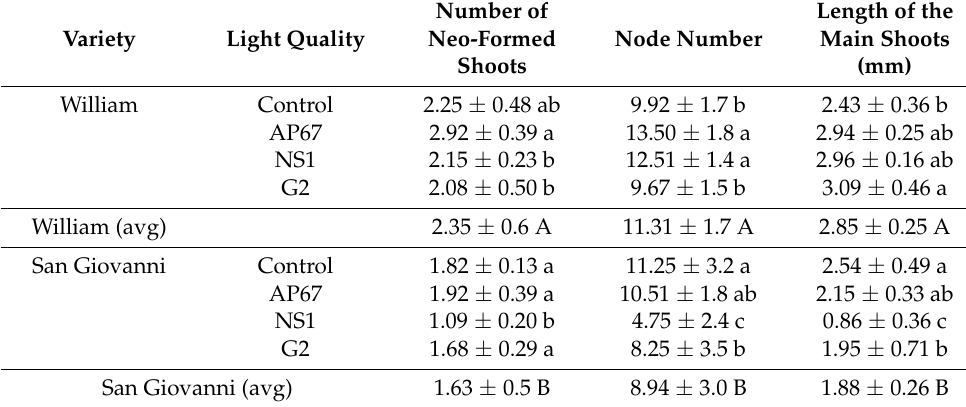
Figure 1. Bud sprout of cv San Giovanni after ten days in forcing solution ( a ), different growth habits of cv William ( b ) and San Giovanni ( c ) after 4 weeks of culture under the same light quality (G2). Callus differentiation at the base of microshoots ( d ) and root differentiation ( e ). Table 2. Number of neo-formed shoots, node number, main internode length (cm) and length of the main shoots (mm) in William and San Giovanni shoots grown under different LED light conditions (AP67, G2 and NS1) and Fluorescent Lamps (Control). Data are represented as mean ± SD. Different lowercase letters on the columns for both varieties indicate significant differences among light treatments (Duncan’s test, p < 0.05). Different capital letters on the columns indicate significant differences among varieties ( t